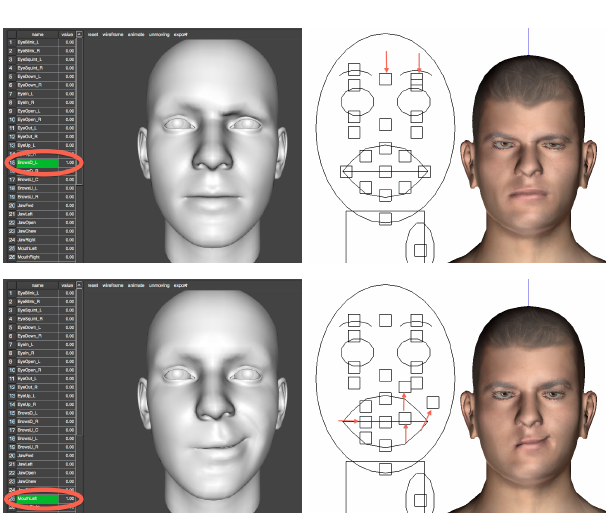
Figure 5. Examples from the calibration procedure of the matrix M . The picture shows the configuration for two of the 48 blend shapes: BrowsD_L (top) and MouthLeft (bottom). The blend shape is shown in the FaceShift configuration panel (left, the active blend shape is highlighted). The resulting expression is manually reproduced (as close as possible) in Blender using the control rig (right, the arrows indicate the moved controllers and the direction of the